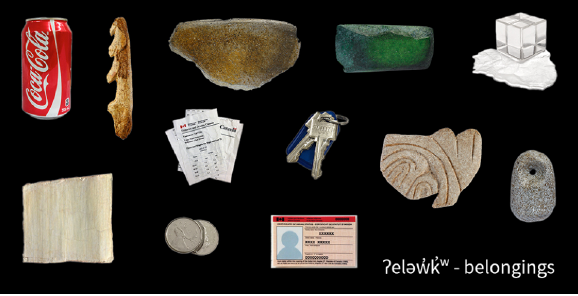
Figure 3 | The twelve contemporary and ancient belongings. Courtesy Reese